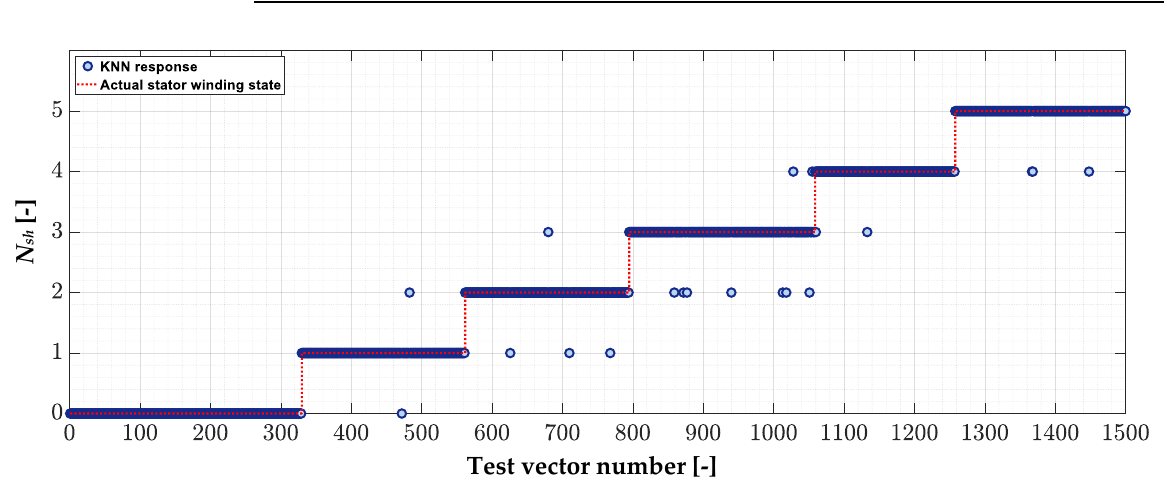
Test vector number [-] Figure 18. Responses of the KNN-based fault classifier model to the test vectors. Figure 18. Responses of the KNN-based fault classifier model to the test